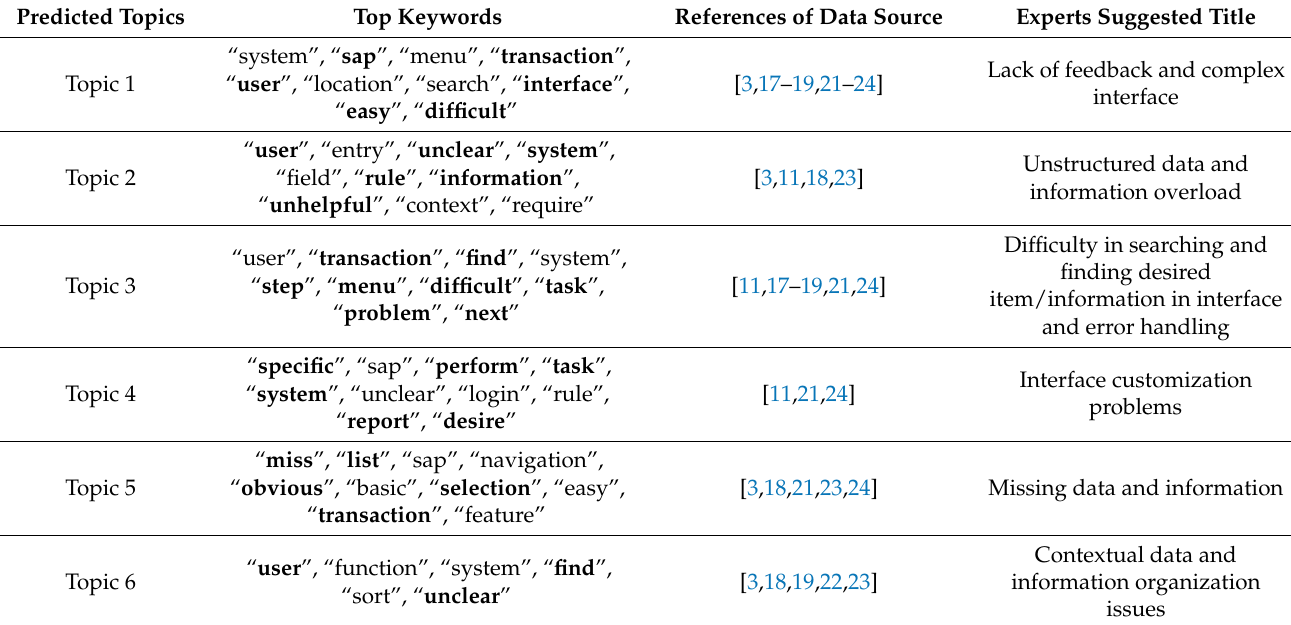
Table 1. LDA calculated topics and their related words and the suggested titles for each topic by an